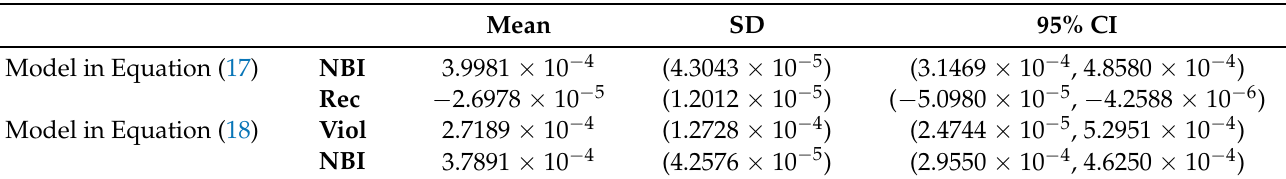
Table 4. Marginal effects at the means for the spatial conditional normal Poisson models in Equations (17) and (18) fitted to the Colombian infant mortality rates data set.